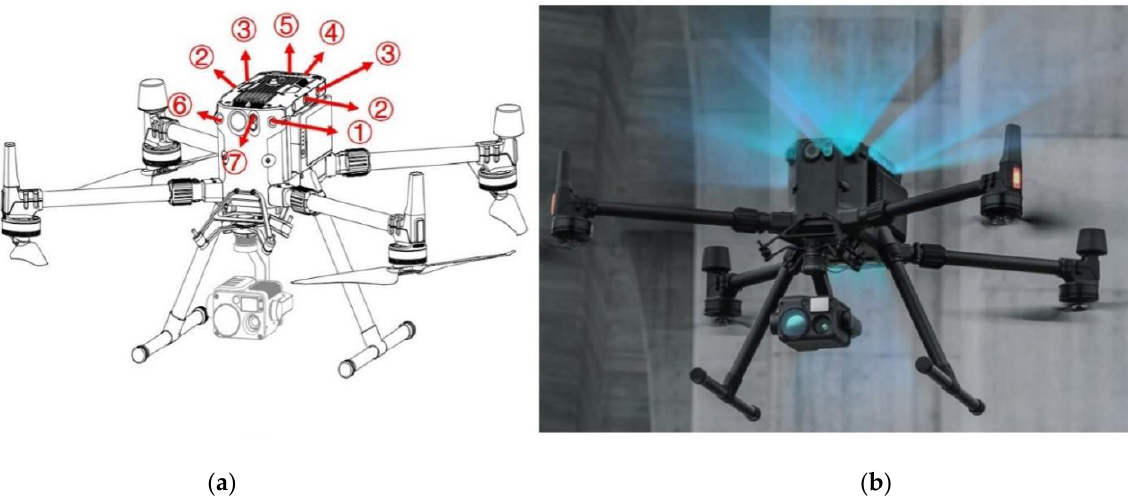
Figure 2. MATRICE M300 RTK six-way sensing system: ( a ) function annotation, and ( b ) product in kind [39 ]. Note: ① front vision system, ② left vision and right vision infrared perception system, ③ left vision and right vision system, ④ top vision system, ⑤ top vision infrared perception system, ⑥ FPV camera, and ⑦ front vision infrared perception system.